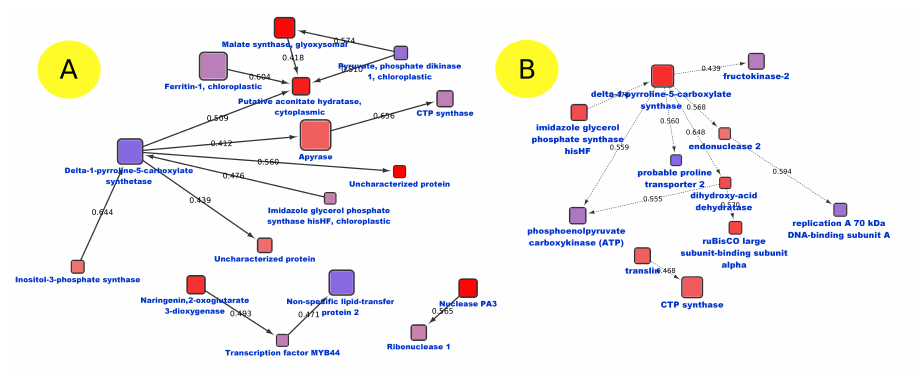
Figure 6. The protein-protein interaction networks of DEGs genes of D.ctrl (A) and HD.ctrl(B) gene profile. The node size and color stand for gene significance (logpvalue) and gene expression (LogFC) .